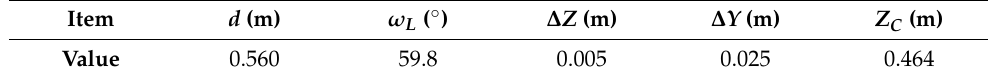
Table 5. Calibration results of eccentric angles and camera orientation to the calibration board.